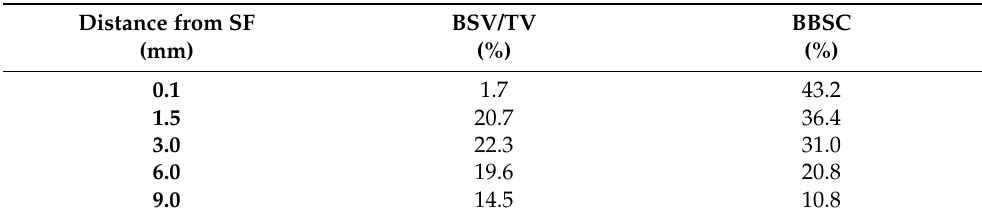
Abbreviations: SF, sinus floor; BSV/TV, bone substitute volume per tissue volume; BBSC, bone-to-bone substitute